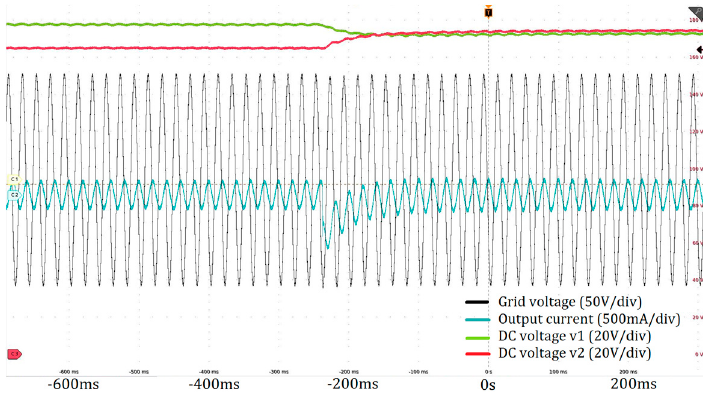
Figure 13. Responses of the inverter in master mode when the DC voltages are imbalance.